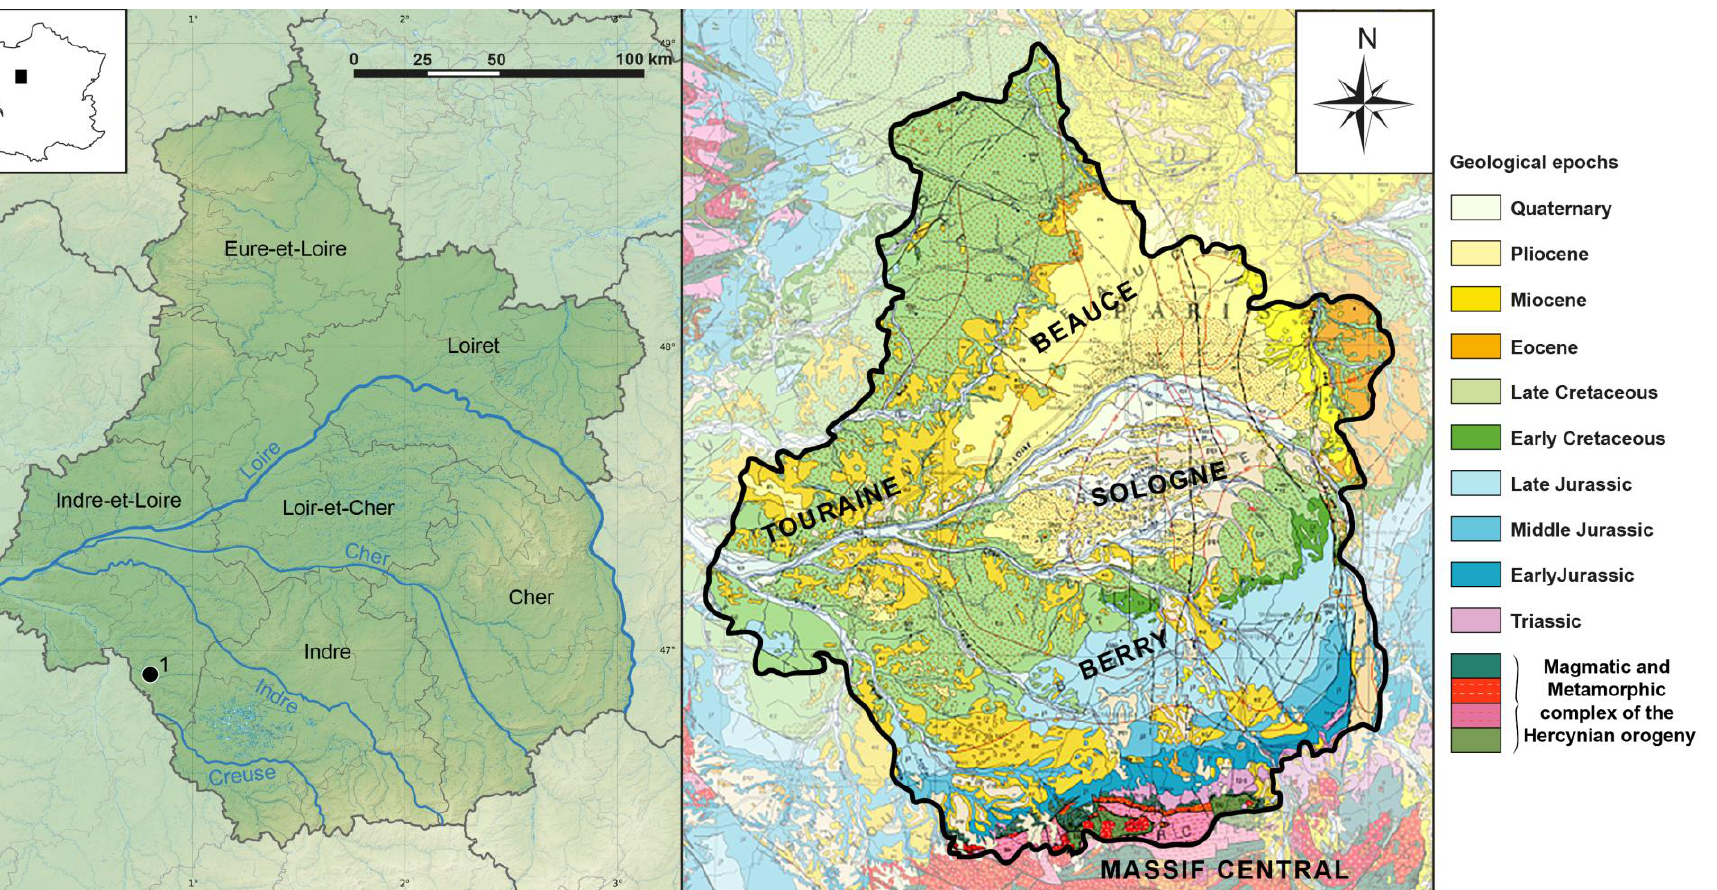
Figure 1. On the left: topographical map of the Centre-Val de Loire région; on the right: geological map of the Centre-Val de Loire region. Black dot (1) represent the Grand-